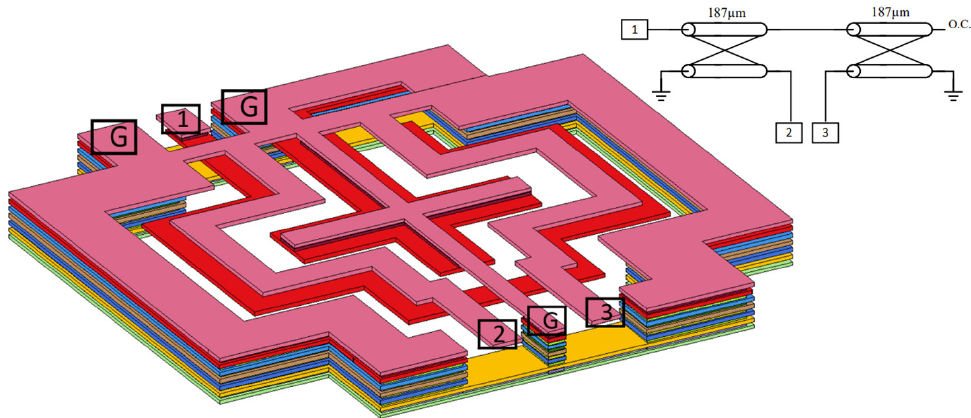
Figure 8. ( a ) Layout of the quadrature − hybrid, ( b ) simulated phase/gain response, and ( c ) simu- lated phase/gain error.